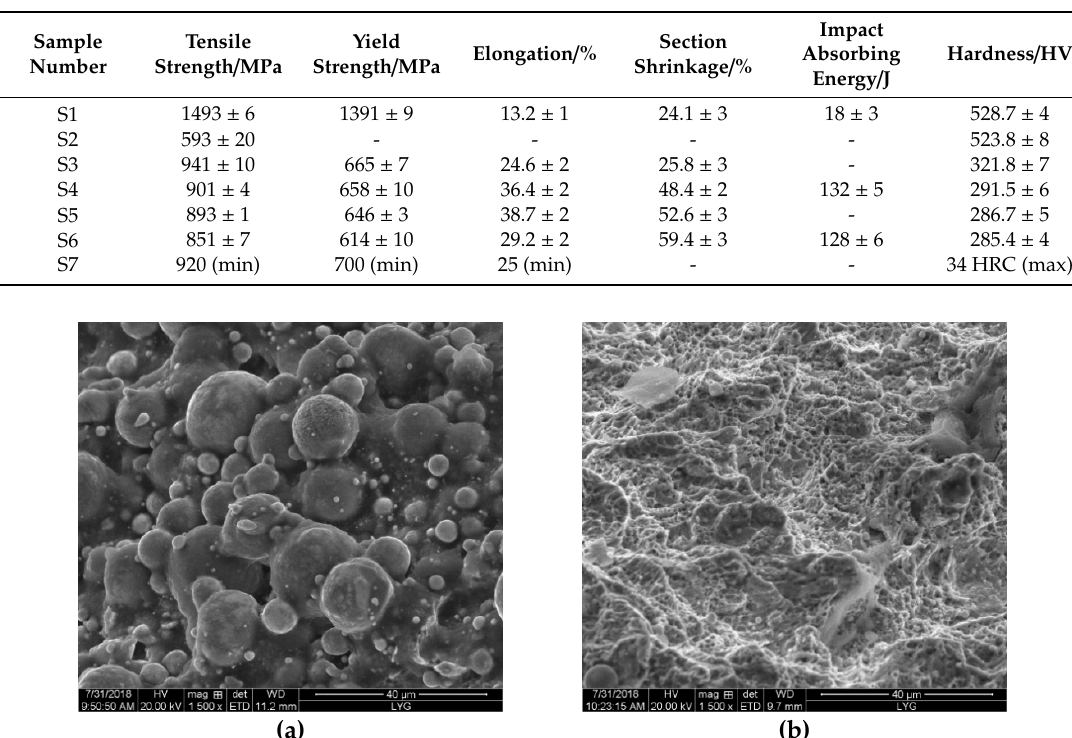
Table 4. The mechanical properties of specimens processed under di ff erent conditions.